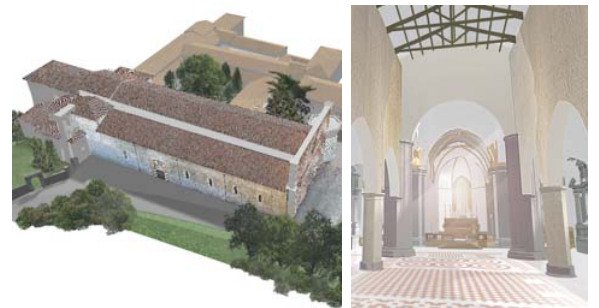
Figure 3. 3D external and internal model views of one of the different solution proposed during the conservation plan of the